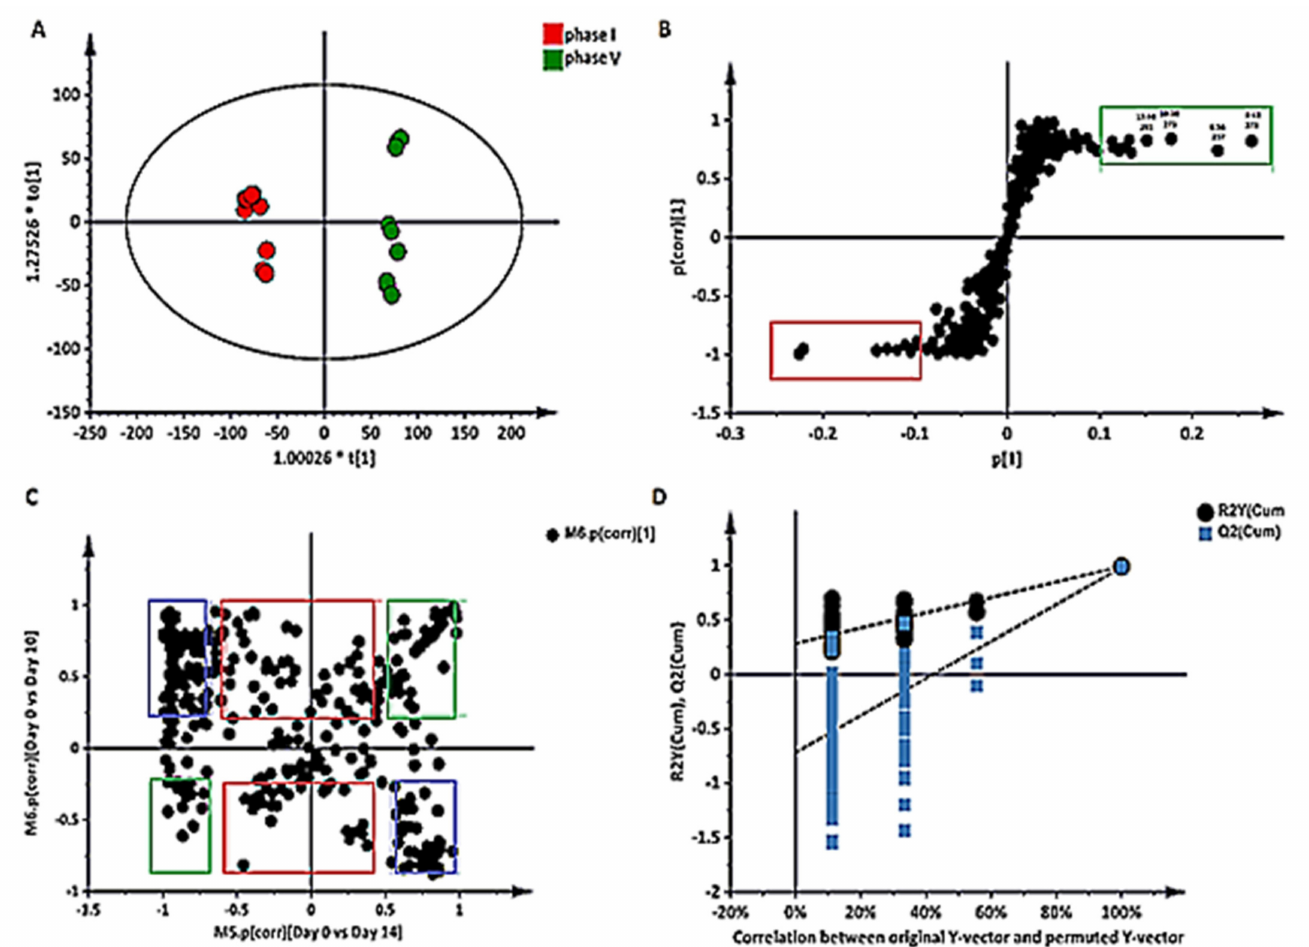
Figure 5. OPLS-DA representative models of DMSO-/methanolic extracts of H. roseoniger cells analyzed by UHPLC–MS. ( A ) A score plot, representing phase I (day 0) vs. phase V (day 14) post sclareol treatment. The x-axis is the modelled covariation, and the y-axis is the loading vector of the predictive component, (R 2 Y ≥ 0.9 and Q 2 = 0.98, respectively). ( B ) The mass ions in the upper right quadrant of the S-plot ( p [1] > 0.1 and p (corr)[1] > 0.05) are positively correlated to the sclareol treatment. ( C ) A SUS (shared-and-unique structures) plot was generated to confirm S-plot findings, where the blue represents shared features, with red and green representing unique features from phase I and phase V, respectively. ( D ) A permutations plot was generated where the model was statistically validated as significant, to confirm the significance of these potential